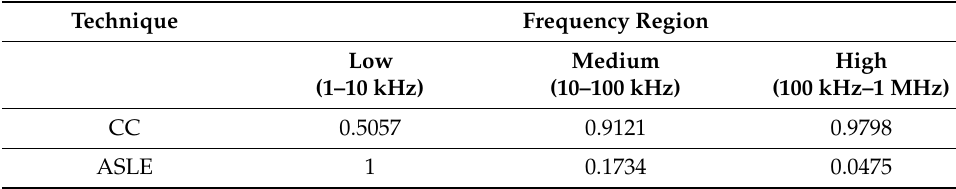
Table 7. Numerical technique results for regulator